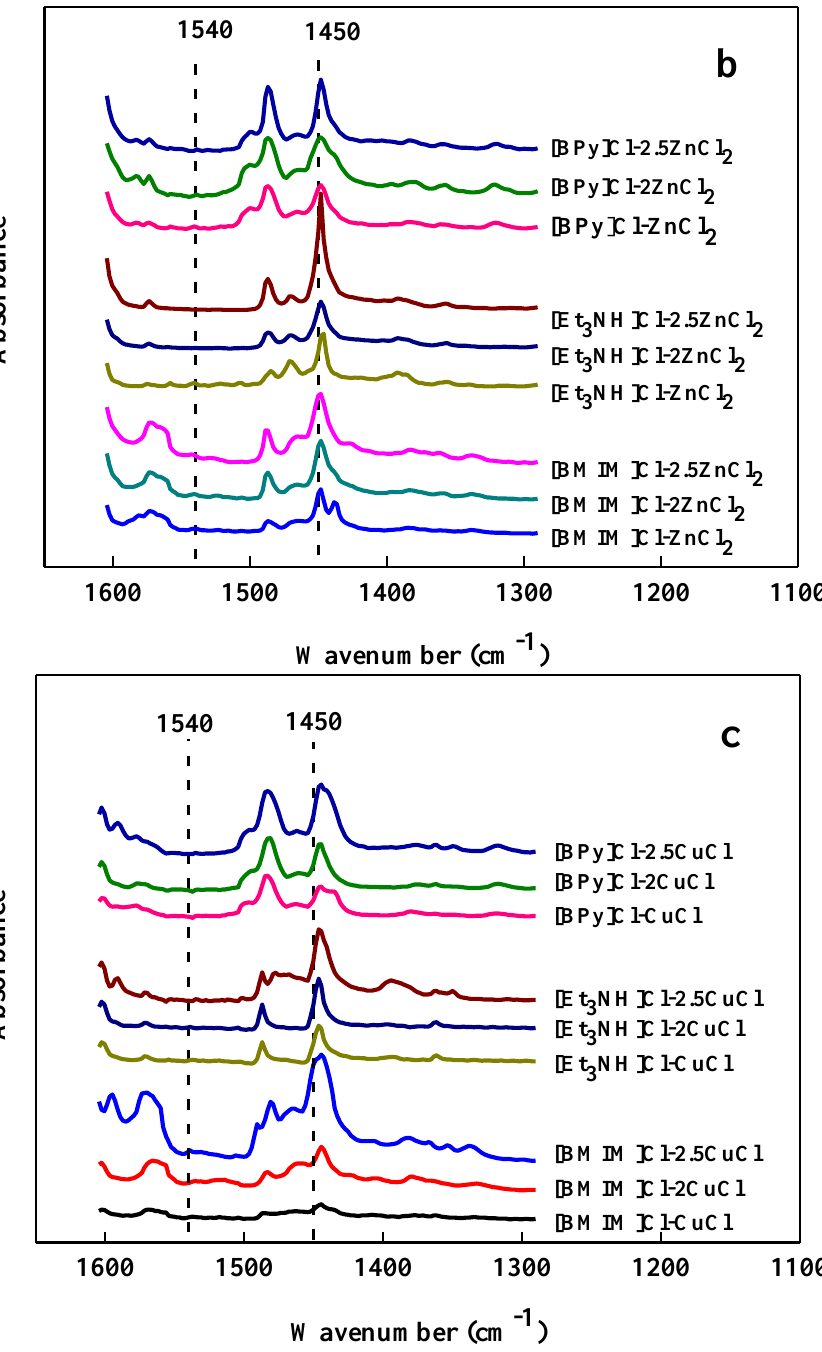
Figure 1. Fourier transform infrared spectroscopy (FT–IR) spectra of ( a ) pyridine/Al n Cl − 3n+1 anion-containing ionic liquids; ( b ) pyridine/Zn n Cl − 2n+1 anion-containing anion ionic liquids; and ( c ) pyridine/Cu n Cl − n+1 anion-containing ionic liquids. The volume ratio of pyridine to ionic liquid is 1:1. When the [BMIM]Cl- n ZnCl 2 , [Et 3 NH]Cl- n ZnCl 2 , and [BPy]Cl- n ZnCl 2 ( n = 1, 2, and 2.5) ionic liquids were mixed with pyridine, IR peaks at 1448, 1449, 1449; 1447, 1448, 1449; 1449, 1449, 1449 cm − 1 were observed (Figure 1b). When the [BMIM]Cl- n CuCl, [Et 3 NH]Cl- n CuCl, and [BPy]Cl- n CuCl ( n = 1, 2, and 2.5) ionic liquids were mixed with pyridine, IR peaks at 1444, 1444, 1444; 1446, 1446, 1446; 1445, 1445, 1445 cm − 1 were observed (Figure 1c). The results indicated that only Lewis acid sites are present in the Zn n Cl − 2n+1 , and Cu n Cl − n+1 anion-containing ionic